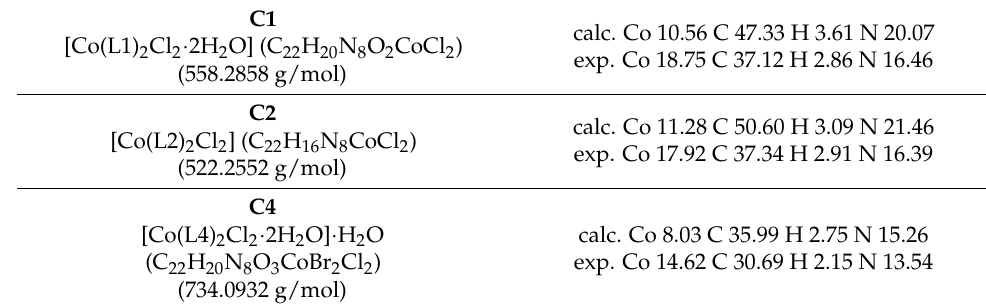
Table 1. Percentage composition of the elements in coordination